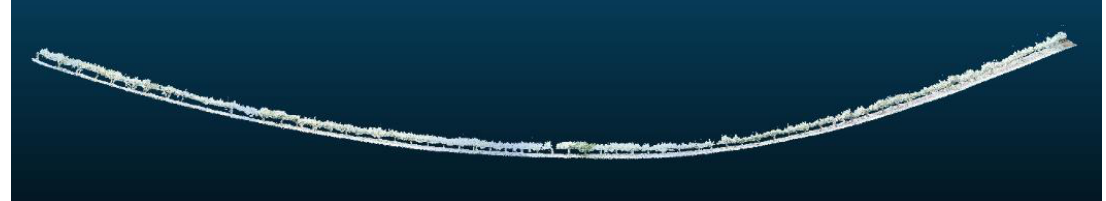
Figure 2. 3D reconstruction of a woody crop row in which the drift problem is observed.